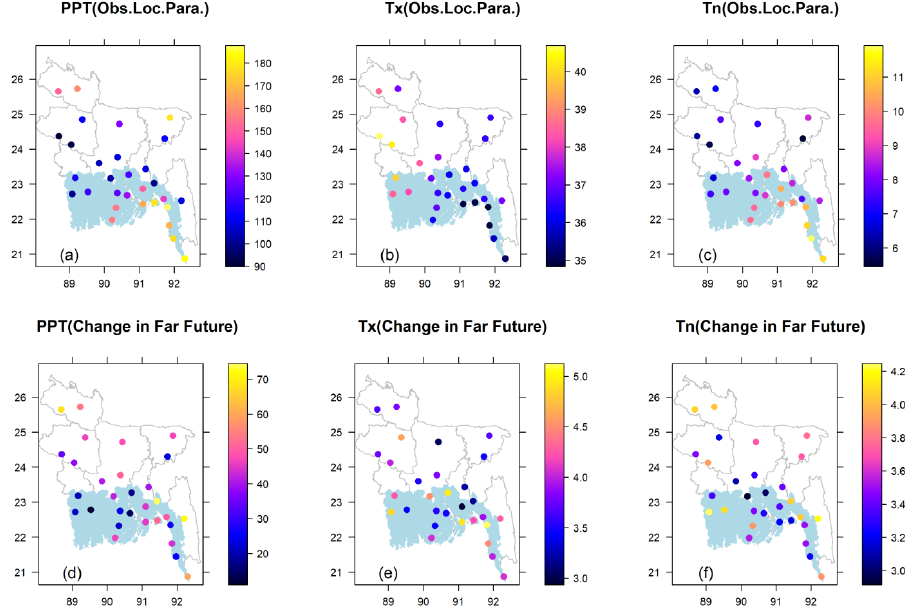
Figure 5. Spatial distribution of location parameters based on observed data, ( a ) PPT, ( b ) Tx, and ( c ) Tn and their changes in location for ( d ) PPT, ( e ) Tx, and ( f ) Tn under climate change with scenario SSP585 in the far future.